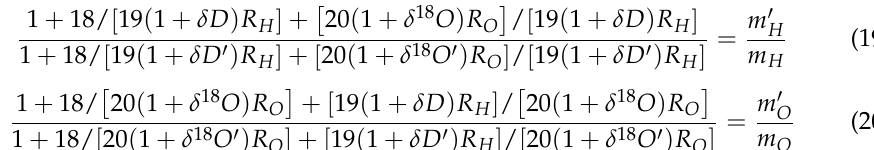
Figure 8. Schematic diagram of isotope exchange processes between the micro-droplet groups and environment water vapor.